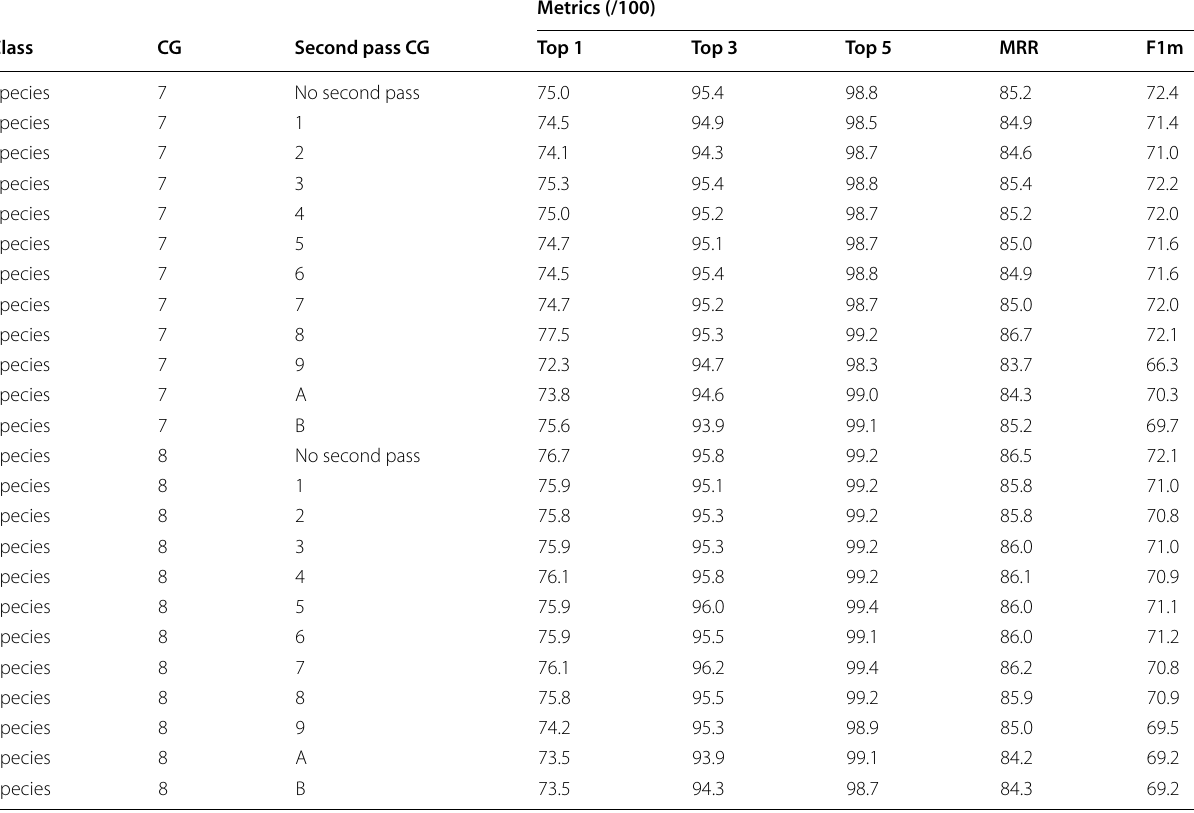
Table 6 Comparison of results where the identifier works in two phases